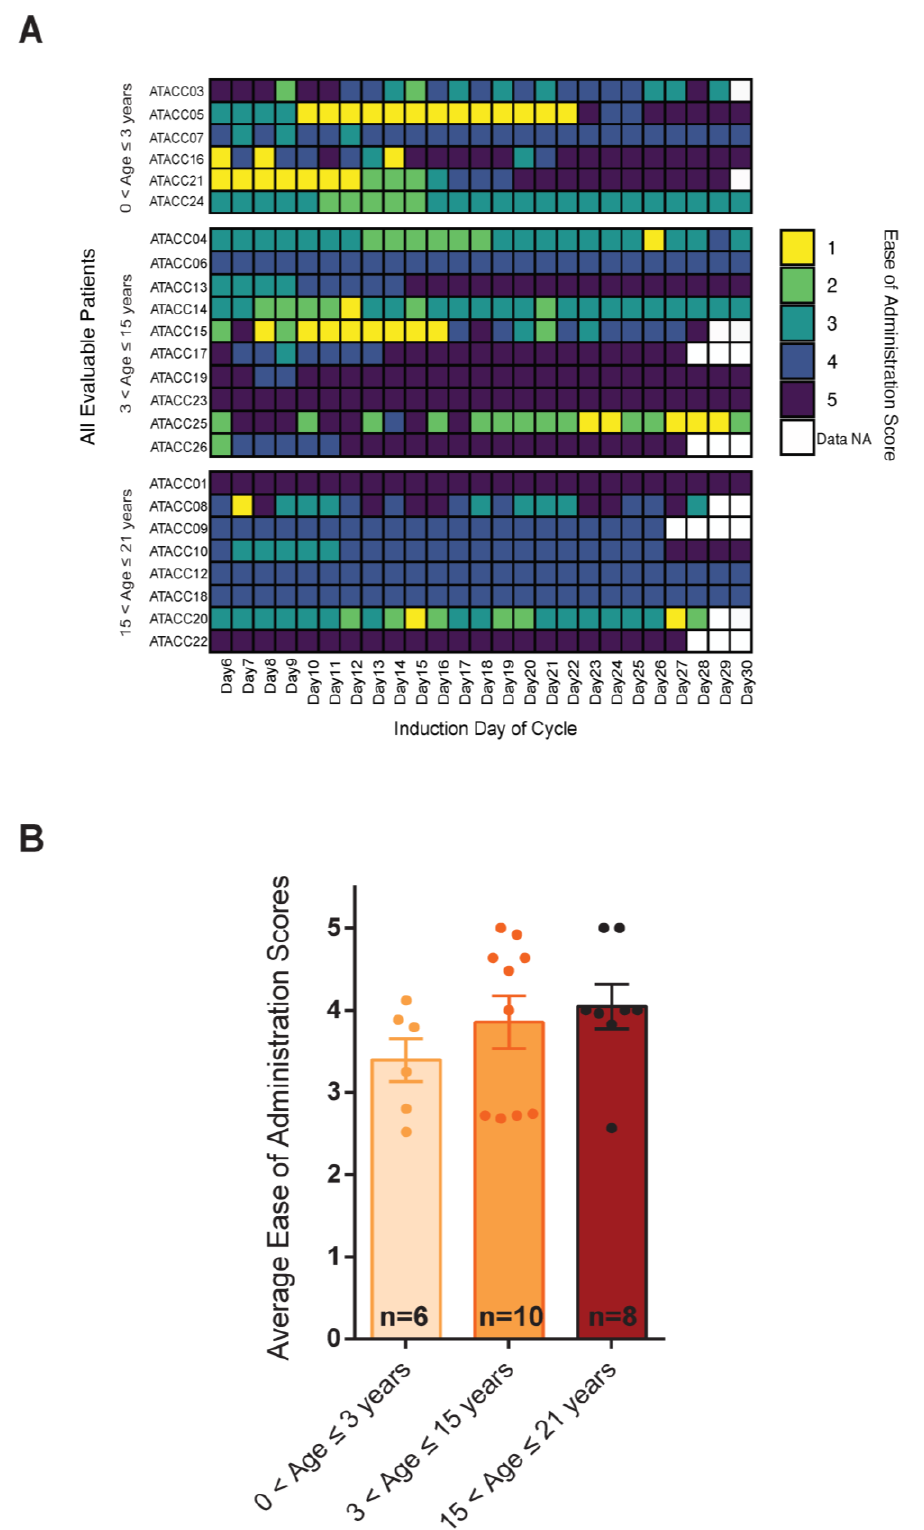
Figure 2. Distribution of ease of administration scores. ( A ) Overview of ease of administration score distribution during administration of atovaquone for all evaluable patients (24) on study, grouped by their age groups. Scoring scale: 1 = very difficult to administer (yellow) to 5 = very easy to administer atovaquone (dark blue). ( B ) Average ease of administration scores for each age group of patients (Error bars represent